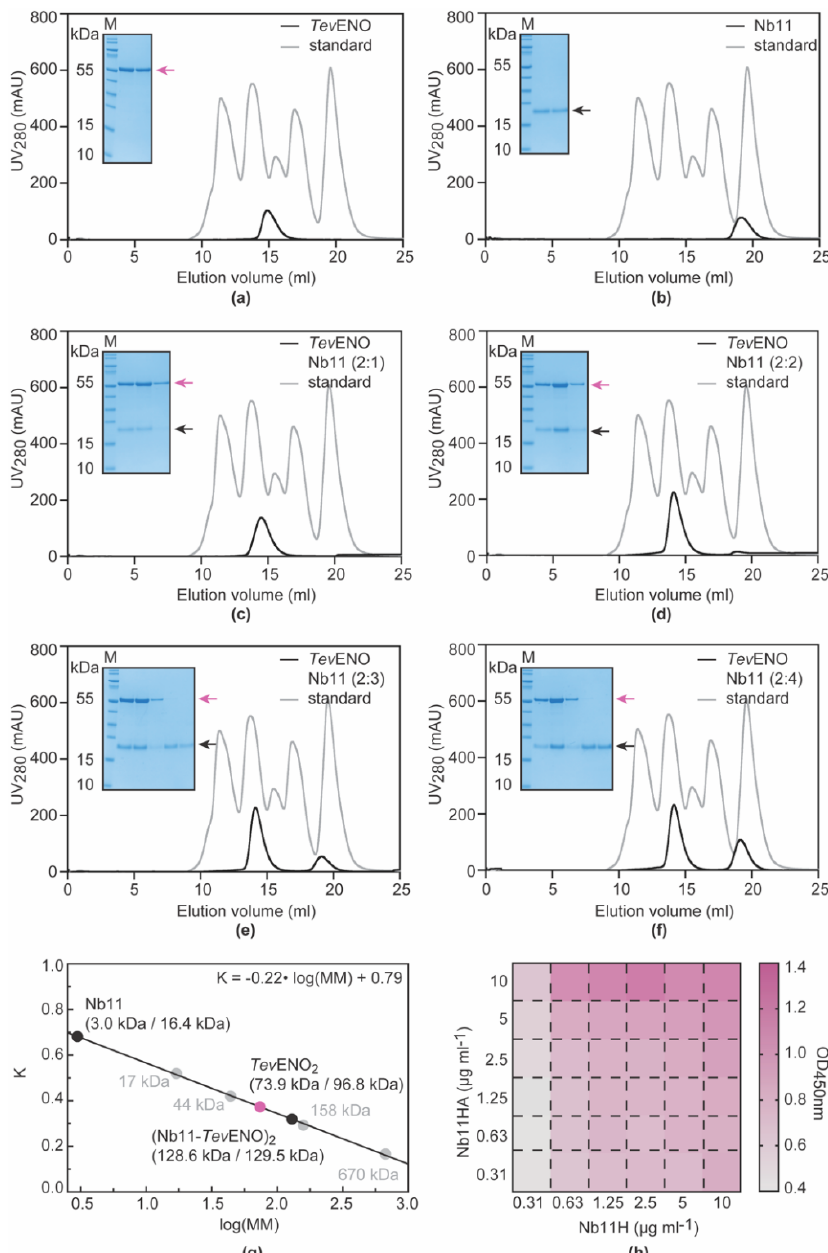
Figure 4. Assessment of the potential use of Nb11 in a homologous immunoassay to detect Tev ENO. ( a – g ) Determination of the stoichiometry of the Tev ENO-Nb11 complex by analytical SEC. Samples containing Tev ENO alone ( a ), Nb11 alone ( b ) and Tev ENO-Nb11 complexes mixed at di ff erent molar ratios: 2:1 ( c ), 2:2 ( d ), 2:3 ( e ), and 2:4 ( f ). All experiments were performed using an ENrich 650 10 / 30 column. The black and grey traces represent the chromatograms of the di ff erent protein samples and the BioRAD gel filtration standard, respectively. In all figures, the inset shows an SDS-PAGE analysis of elution peaks. Tev ENO (MM = 48.41 kDa, monomer) and Nb11 (MM = 16.35 kDa) are indicated by the purple and black arrows, respectively. Lane M , PageRuler Prestained Protein Ladder. ( g ) The calibration of the ENrich 650 10 / 30 column that allows molecular mass estimation based on the sample’s elution volume. The values between brackets indicate the estimated versus the theoretical molecular mass of the sample under investigation. ( h ) Heat map representation of the results of the Nb11-based homologous sandwich